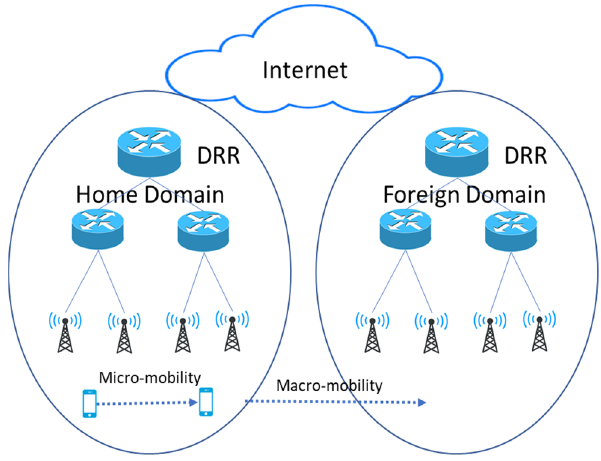
Figure 1. Micro versus macro mobility.